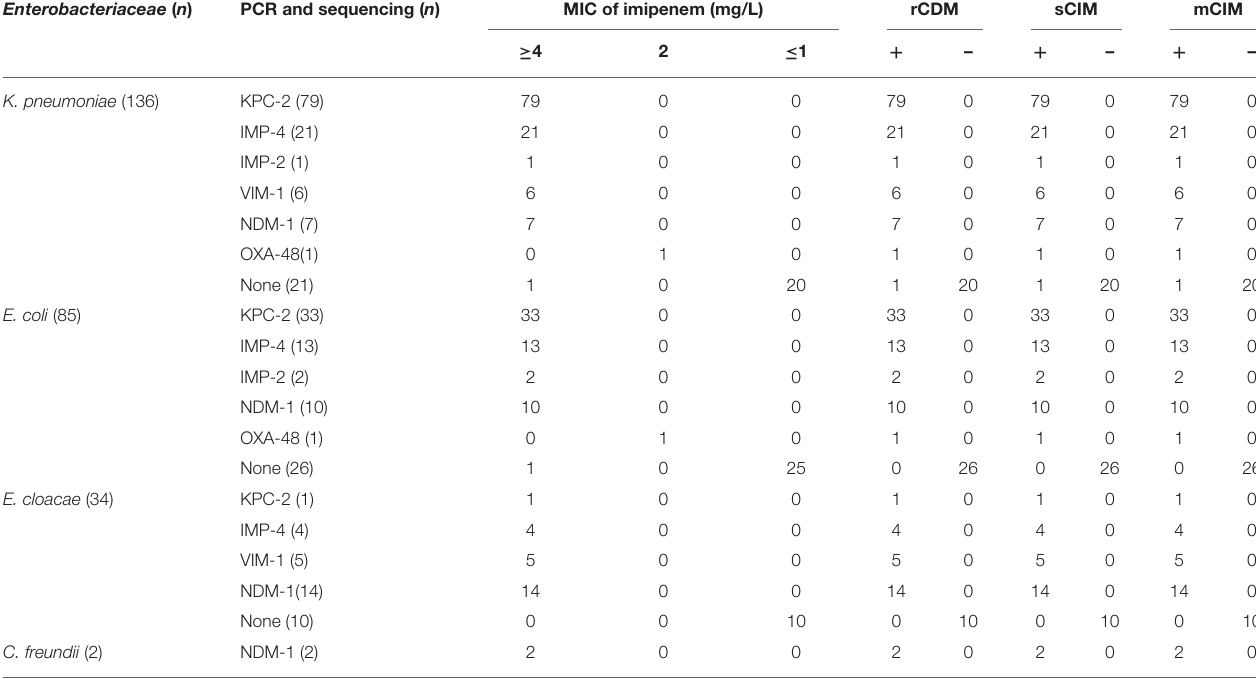
TABLE 1 | Detection of carbapenemases in Enterobacteriaceae isolates by rCDM, mCIM, and sCIM.